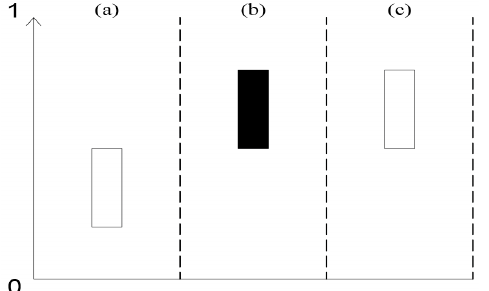
Figure 12. Illustration of negation in the LBIFS-IBA approach on the example of candlestick modeling: ( a ) a single candlestick; ( b ) negation of the candlestick given in ( a ) in LBIFS-IBA approach; ( c ) negation of the candlestick given in ( a ) in traditional IFS approach.